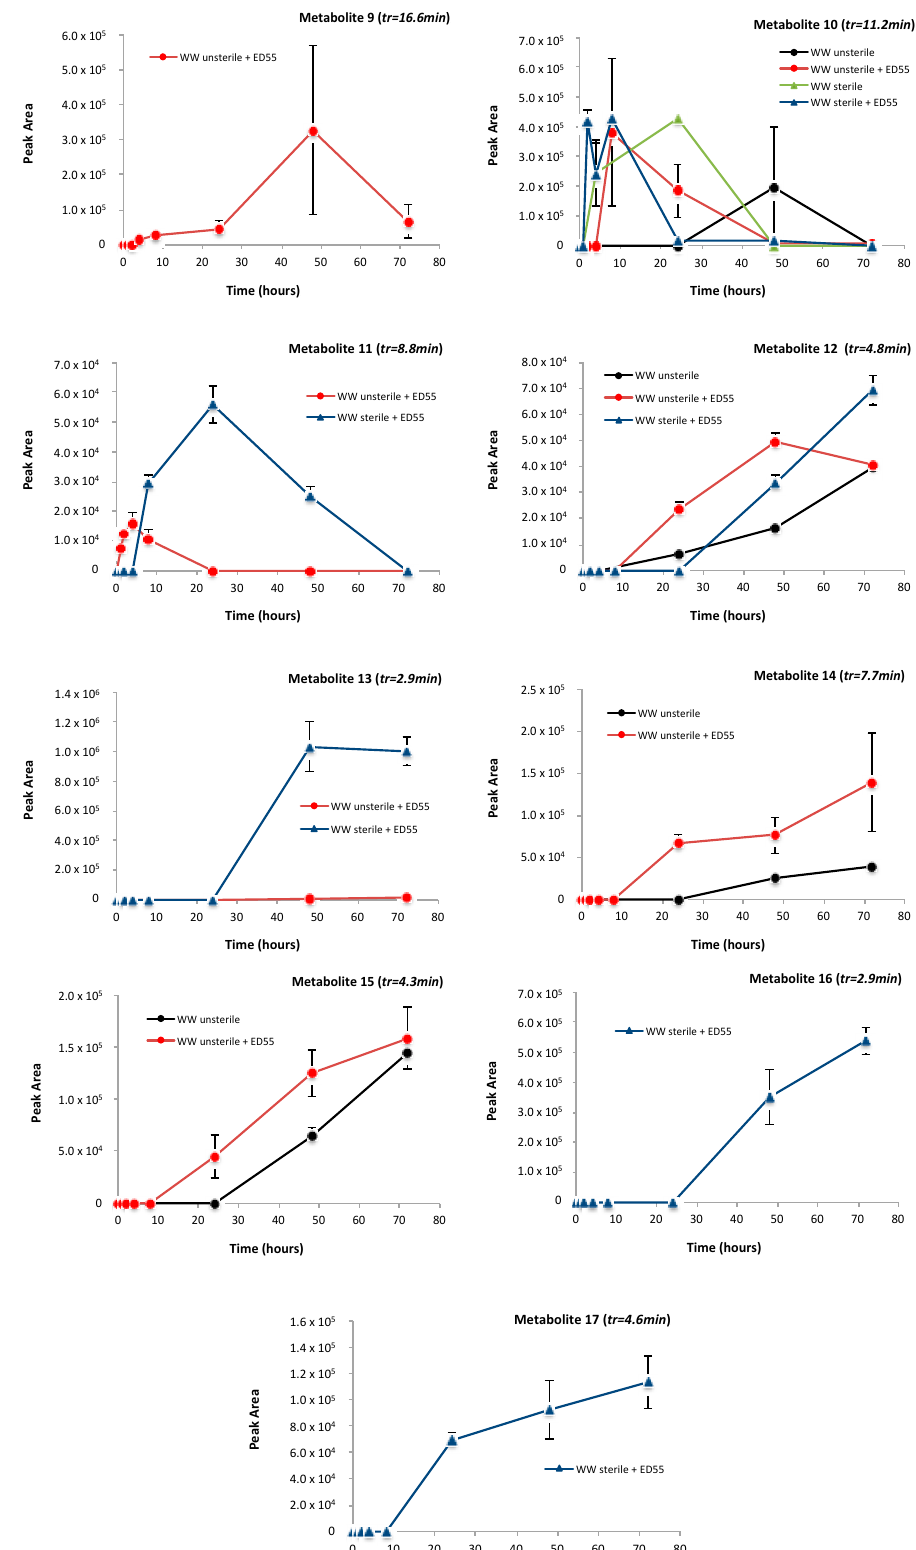
Figure 5. Time profiles of detected metabolites under investigated treatments, namely WW unsterile and sterile, both supplemented with E2 in the presence of bacterial strain ED55 and without the bacterial strain. The present work, as well as the work by Lee and Liu [32], Chen et al. [31], Li et al. [26], suggested that the initial transformation of E2 after exposition to sewage microor- ganisms occurred in ring D, producing the estrogen E1 (estrone). As shown in the time profile in Figure 5, both E1 (metabolite 1) and 4-OH-E1 (metabolite 2) are produced from the metabolism of the ED55 and other bacteria from WW being detected in unsterile and sterile WW samples when inoculated with the bacterial strain. Another estrogen-like chemical, namely pyridinestrone acid (metabolite 7), already documented in previous re- ports [26,31,34] was detected only in WW unsterile samples both in the presence and ab- sence of ED55, suggesting that it is produced by ED55 and other bacteria from WW. The same profile was observed for metabolites 3, 14 and 15 with a constant increase in intensity along the reaction time. Differently, metabolites 13, 16 and 17 are clearly produced from the biodegradation of E2 by Rhodococcus sp. ED55, being detected only in WW sterile sup- plemented with bacterial strain. In fact, since the wastewater is autoclaved, it is most likely that the E2 degradation is due to the presence of the bacterial ED55. Moreover, it is worth noting that for the metabolites E1, 4-OH-E1 and 4-OH-E2 (metabolite 1, 2 and 5, respec- tively), even in the presence of the bacterial community naturally present in the wastewater (WW unsterile), the bioaugmentation with ED55 determines a faster and com- plete removal of the produced metabolites. 2.5. Toxicity Tests The risk of producing metabolites with higher toxicity than the parent compound was evaluated by monitoring changes in whole sample toxicity. The results obtained for the Allivibrio fischeri bioluminescence inhibition revealed a decrease in whole sample